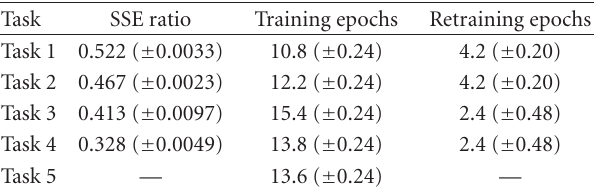
Figure 3: The number of training trials required to reach criterion ( y -axis) decreases as the number of prior acquisition and extinction training sessions ( x -axis) increases. Error bars report standard errors of the mean. Table 5: SSE ratio and retraining epochs.